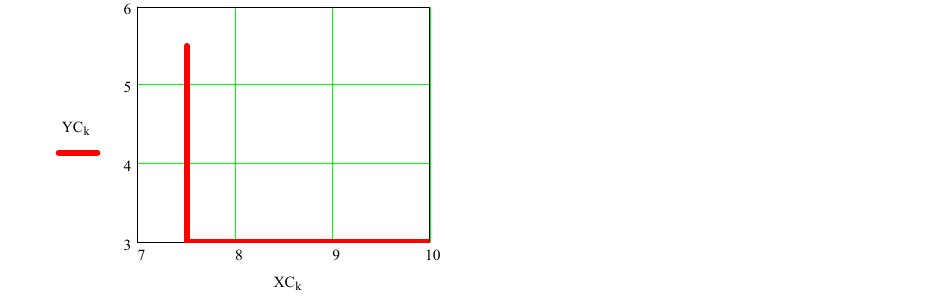
Figure A1. The hodograph of the end effector point C is the trajectory described by the end effector C. Reverse kinematics on a planar 2R robot.